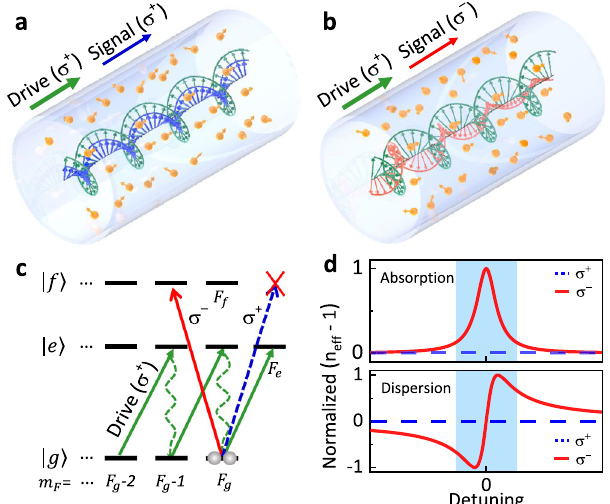
Fig. 1 Schematic of circular birefringence and circular dichroism arising from optically-induced magnetization. a , b In an atomic medium with non- zero magnetization induced by a σ + -polarized drive fi eld, the σ + - and σ − -polarized signals propagate at different velocities and experience different absorption losses. c The energy diagram of typical atoms or atomic-like emitters, with degenerate ground Zeeman levels ( g j i ) and the allowing optical transitions to excited energy levels ( e j i , f j i ). The drive fi eld ( g j i ! e j i ) induces the magnetization of the atoms as the population concentrates to one side of the Zeeman levels, which leads to the different response to σ + - and σ − -polarized signals ( g j i ! f j i ) due to selection rules. d The illustration of absorption and dispersion in a magnetized atomic medium for σ + - and σ − -polarized signals. Absorption dominates in the shadow region where the signal is near-resonant to the atomic transitions, while dispersion dominates for off-resonant